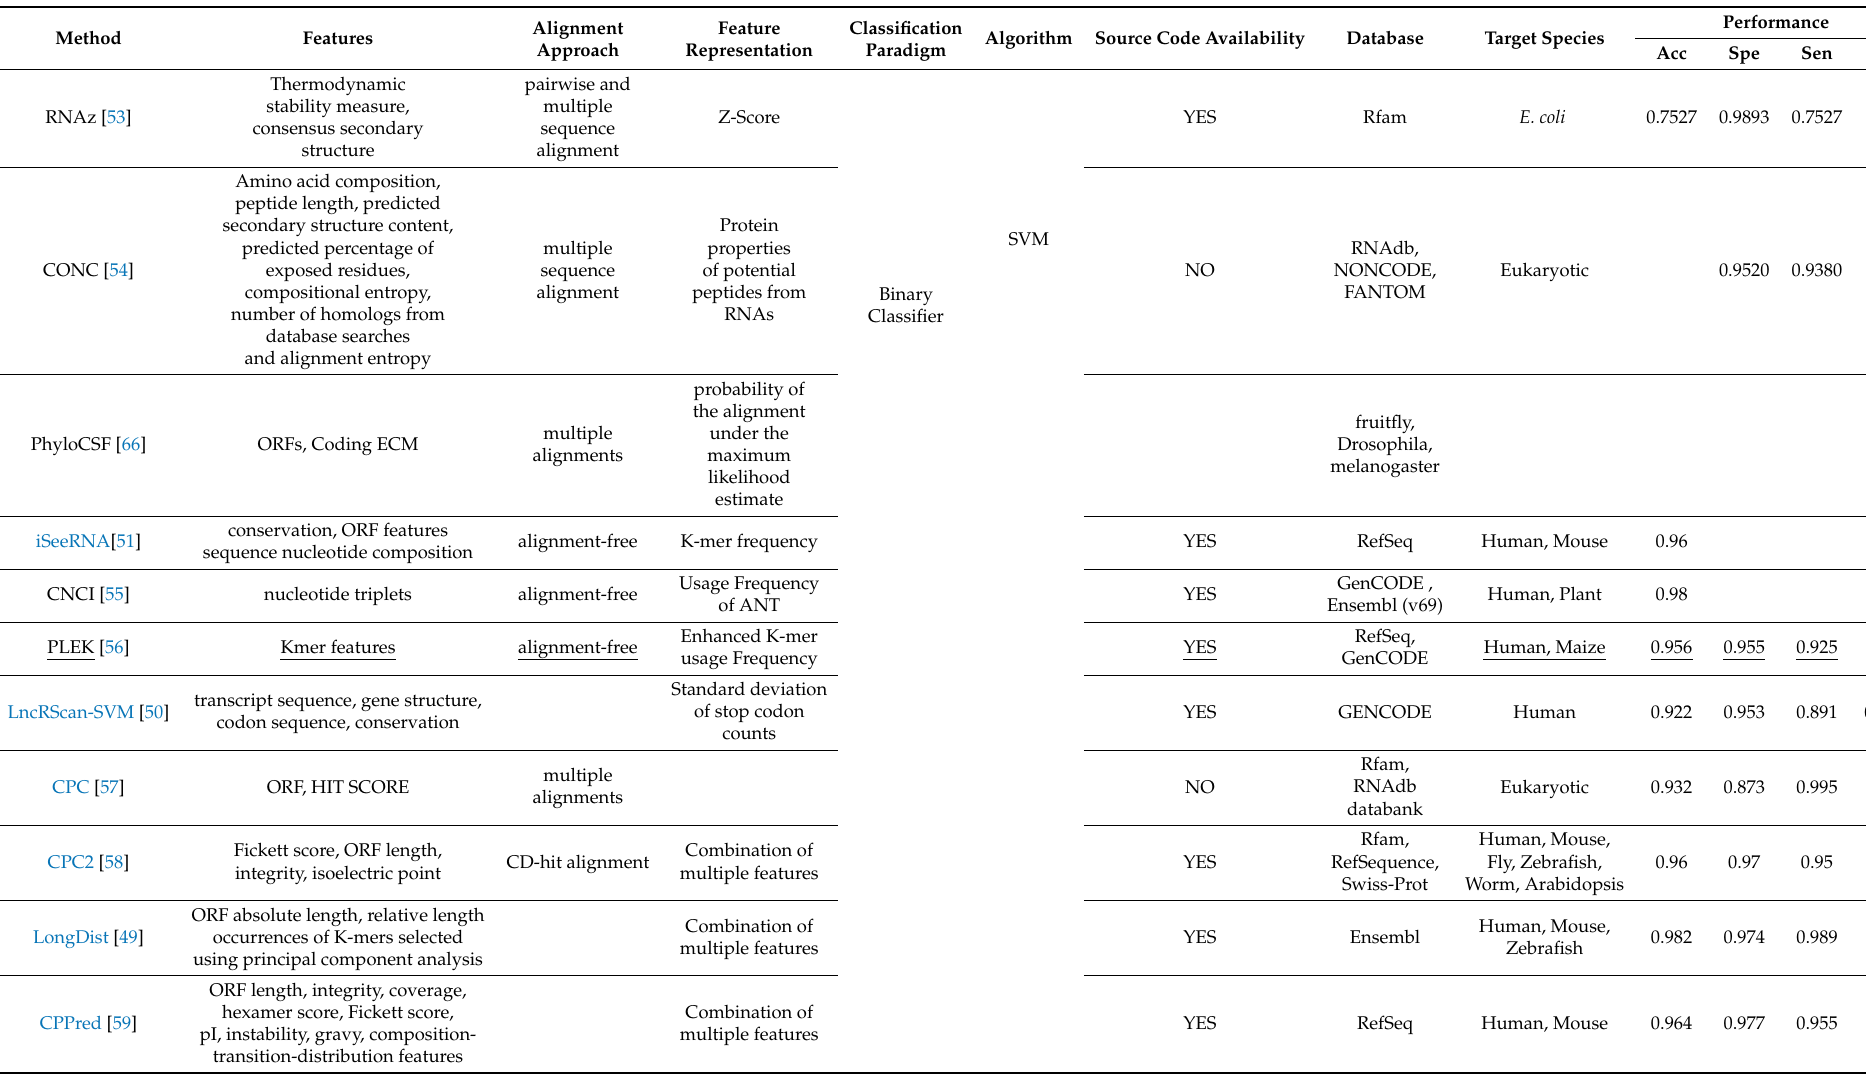
Table 1. A broad classification of computational approaches proposed to distinguish LncRNAs from protein-coding